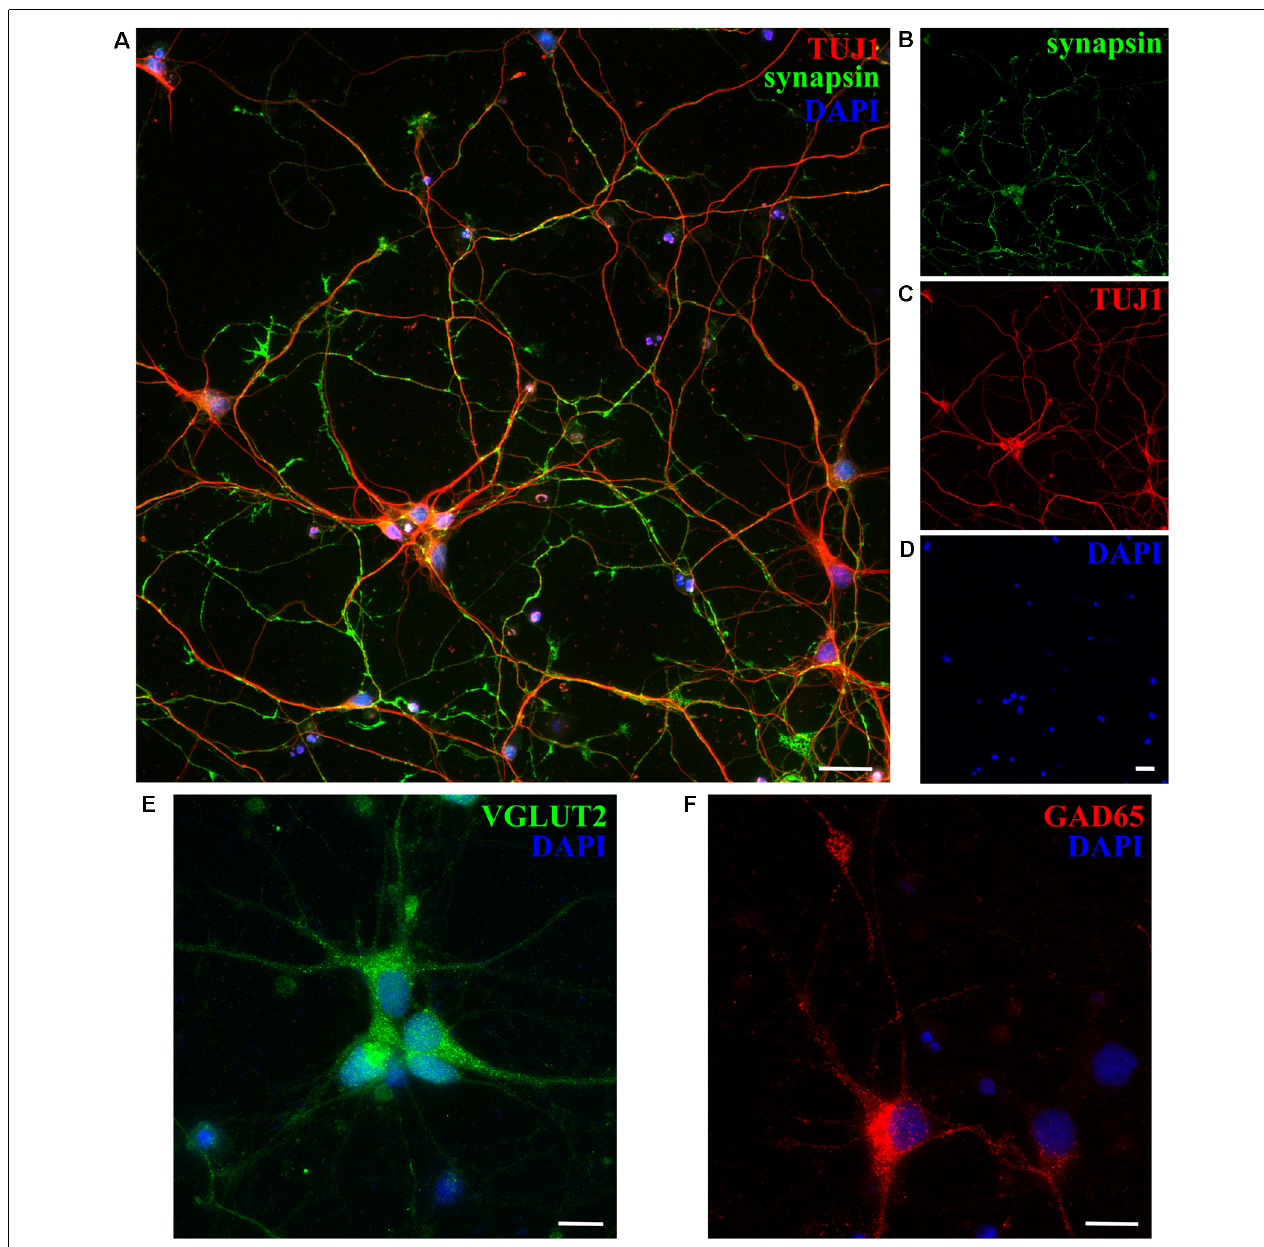
FIGURE 4 | Expression of synaptic and neuronal subtype markers at DIV15 of cortical cultures obtained from P5 opossums. (A) Merged image of staining for (B) synapsin (green; C ) β -tubulin III (TUJ1, red) and (D) DAPI nuclear stain (blue). (E) Excitatory VGLUT2-positive (green), (F) GABAergic inhibitory GAD65-positive (red) neurons, and DAPI-positive nuclei (blue), respectively. Scale bar, 25 µ